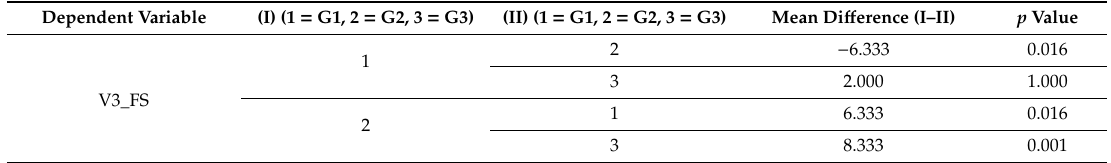
Table 7. Intergroup comparisons of changes in rectal volume sensation at